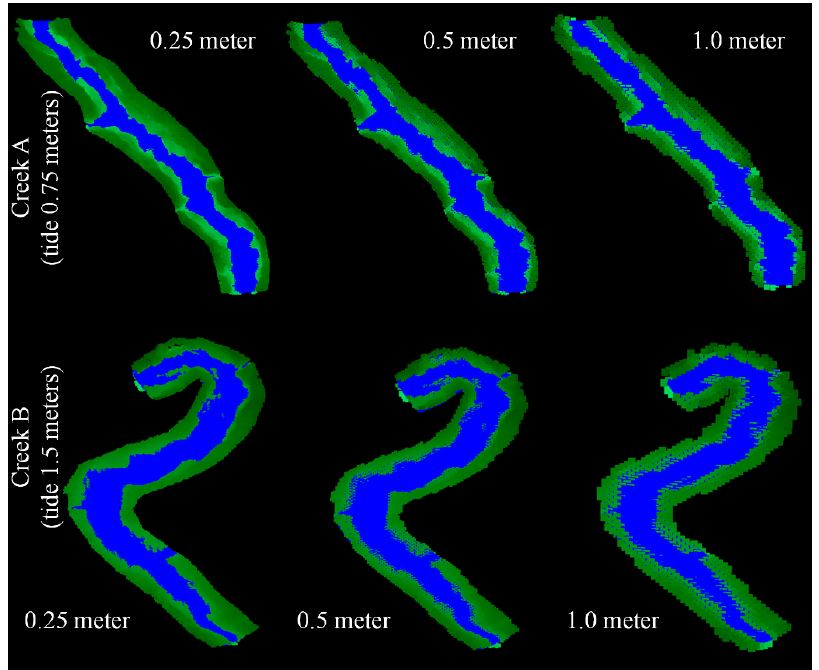
Figure 7. Modelling of tidal height to estimate water volume and surface area (blue) based on terrestrial lidar acquisitions of two sections of saltmarsh creek within the study site (green), degraded to coarser resolutions to represent potential airborne lidar acquisitions.